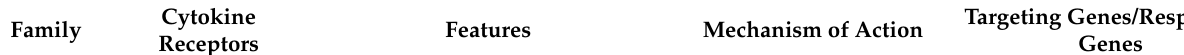
Table 1. Cytokine receptor families involved in the antimycobacterial immune